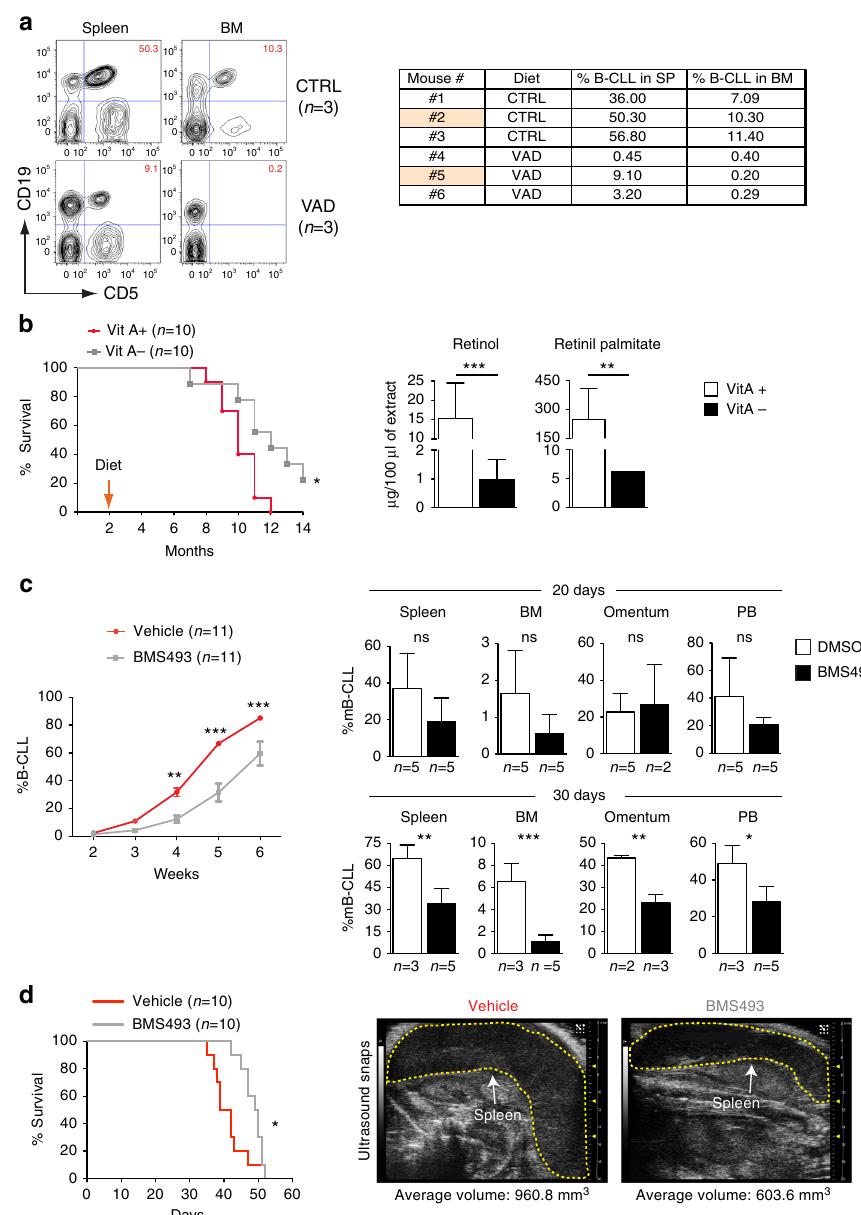
Fig. 5 Targeting RA-signaling controls disease progression and prolongs survival. a FACS analysis of control mice ( n = 3) or VAD ( n = 3) injected with leukemic cells. The table summarizes the percentage of murine E μ -TCL1 CLL cells in spleen and BM for each mice analyzed. b Survival curve for E μ -TCL1 mice fed with vitamin A de fi cient (VitA – ) or control (VitA + ) diet. Quanti fi cation of RA-precursors retinol and retinyl palmitate in the liver of moribund E μ -TCL1 VitA + or VitA – fed mice. The mean of triplicates and ±SD are shown, * p < 0.05, ** p < 0.01 and *** p < 0.001. c Analysis of leukemia progression over time in wild type mice transplanted with leukemic cells and treated with vehicle (DMSO) or BMS493. Flow cytometry analysis of leukemia cell in fi ltration in different tissues at 20 or 30 days after the indicated treatment, * p < 0.05, ** p < 0.01 and *** p < 0.001. d Survival curve of wild-type mice transplanted with E μ -TCL1 CLL cells and treated with vehicle (DMSO) or BMS493, * p < 0.05. Representative ultrasound images and echographical measurement of the spleen size performed at day 35 of disease progression